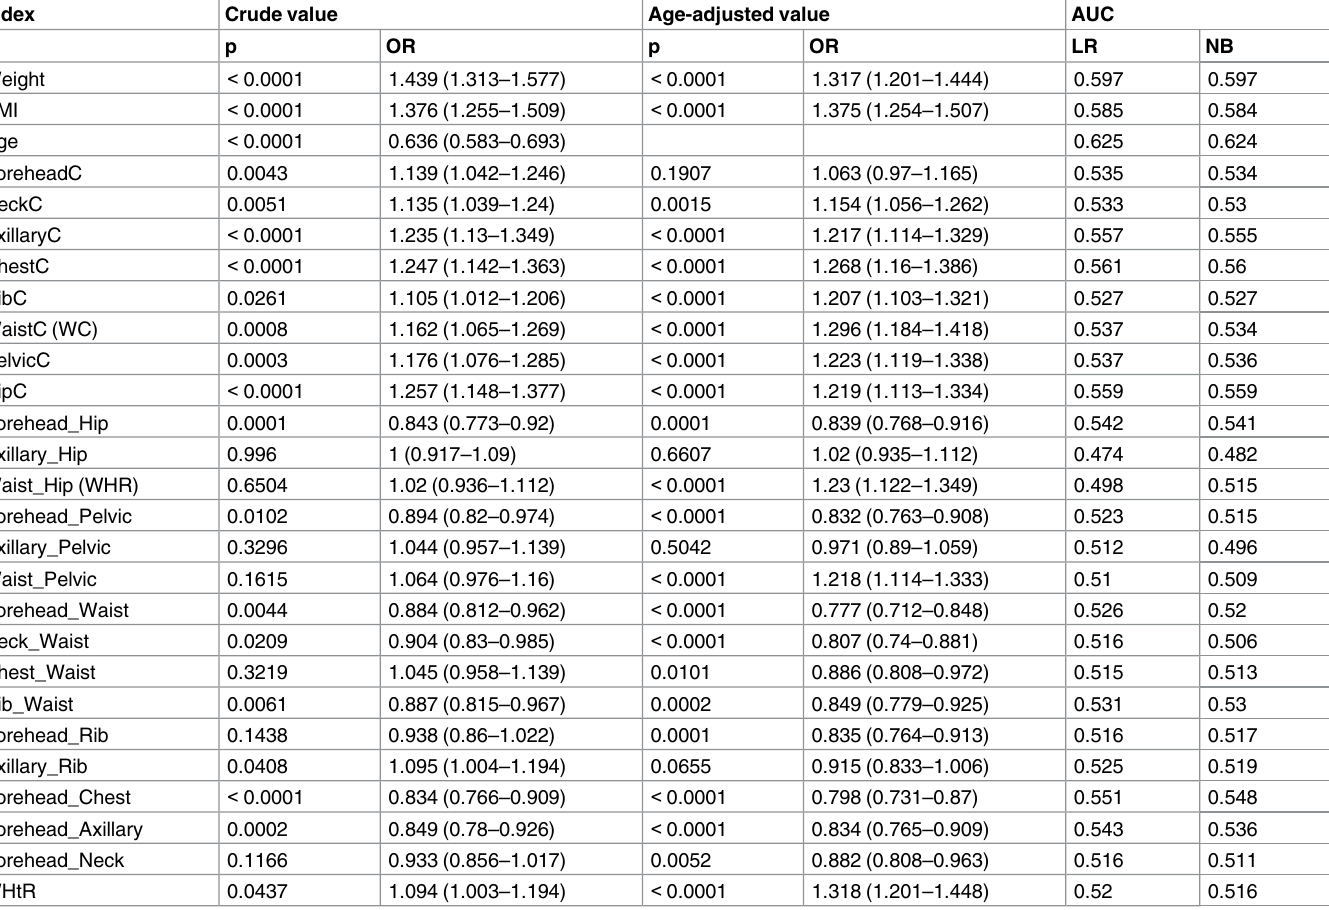
Table 3. The associations between anthropometric indices and the hemoglobin level in